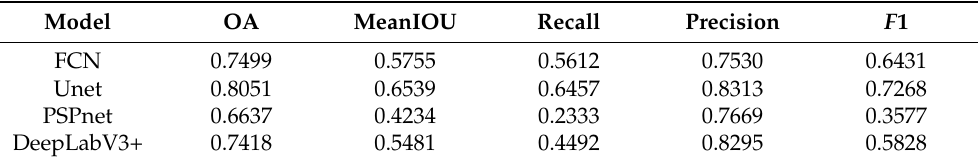
Table 2. Results of accuracy evaluation of classical semantic segmentation models for extracting marine raft aquaculture areas.